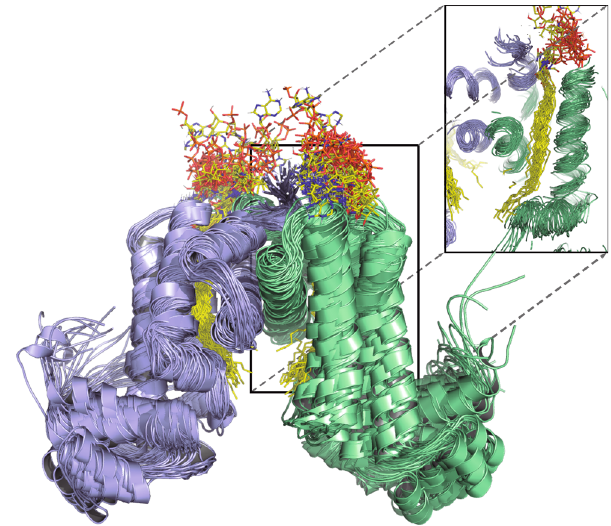
Table 1 FasR association to DNA, and dose-dependent inhibition by effector ligands.